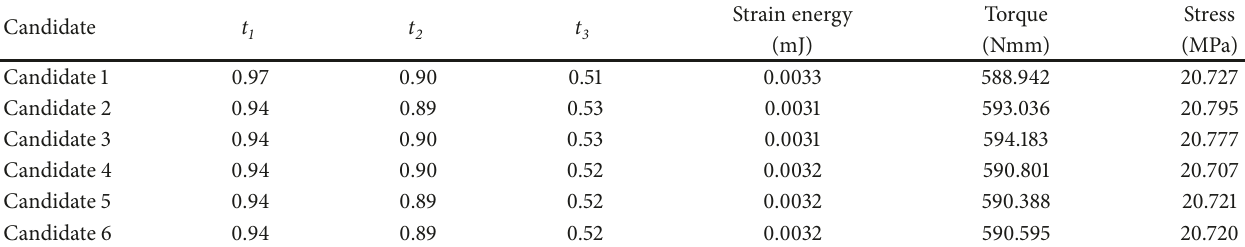
Table 8: Potentially optimal candidates.